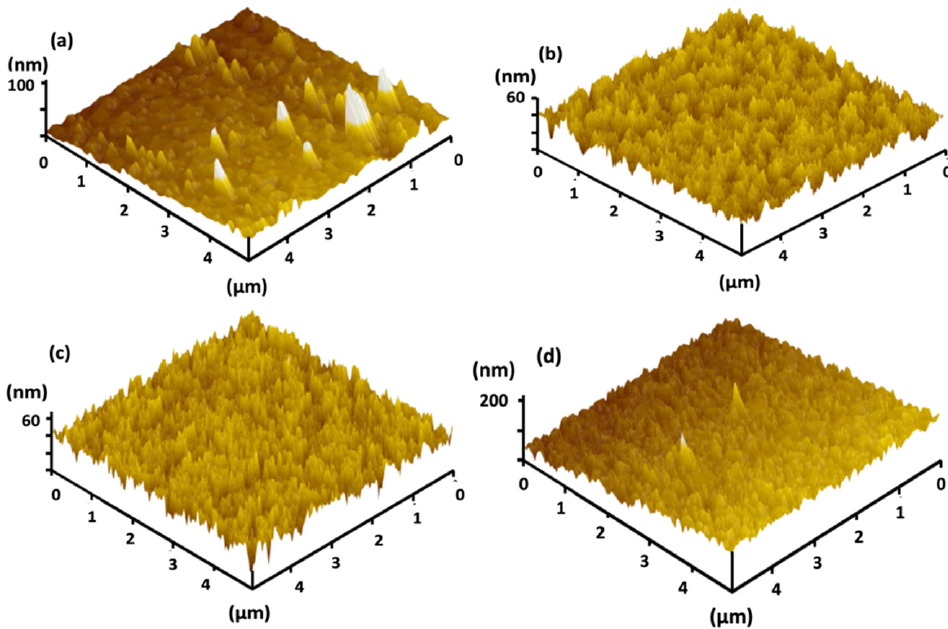
Figure 3. Three-dimensional AFM images of V 2 O 5 thin films ( a ) without annealing ( b ) 200 °C-annealing, ( c ) 300 °C-annealing, and ( d ) 400 °C-annealing.